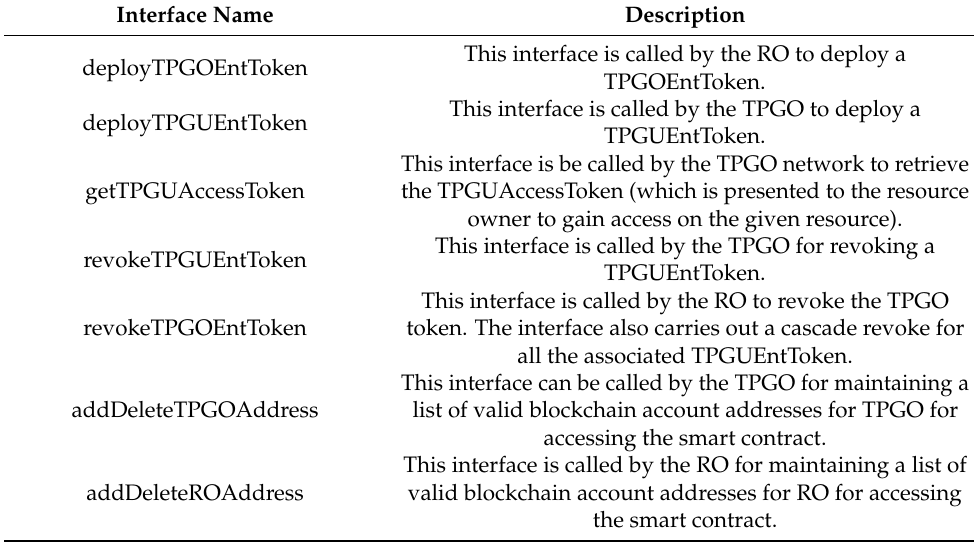
Table 2. Third-Party Entitlement Smart Contract Interfaces